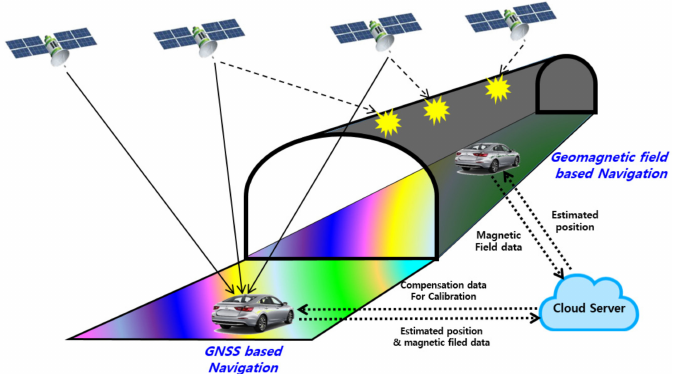
Figure 1. Tunnel navigation using a magnetic